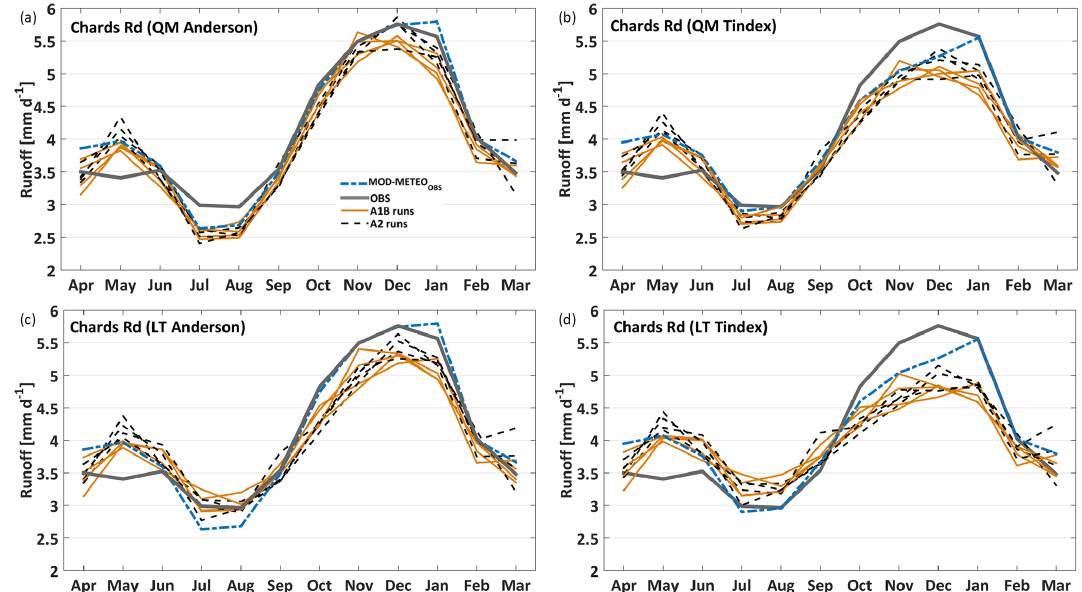
Figure 5. RCM-driven mean daily runoff simulations for the 1 April 1992–30 March 2011 period at Chards Rd. Simulations are compared with the observed regime (grey line) and the modelled (WaSiM forced with observed meteorology) regime (blue line) for the four sub- ensembles: (a) QM-Anderson, (b) QM-Tindex, (c) LT-Anderson and (d) LT-Tindex. Table 3. The historic (1 April 1992–30 March 2011) water balance terms of the MOD-METEO OBS run compared with the corresponding (depending on snow model) RCM sub-ensemble means (QM and LT). The seasonal and annual SWE values are also shown. Anderson